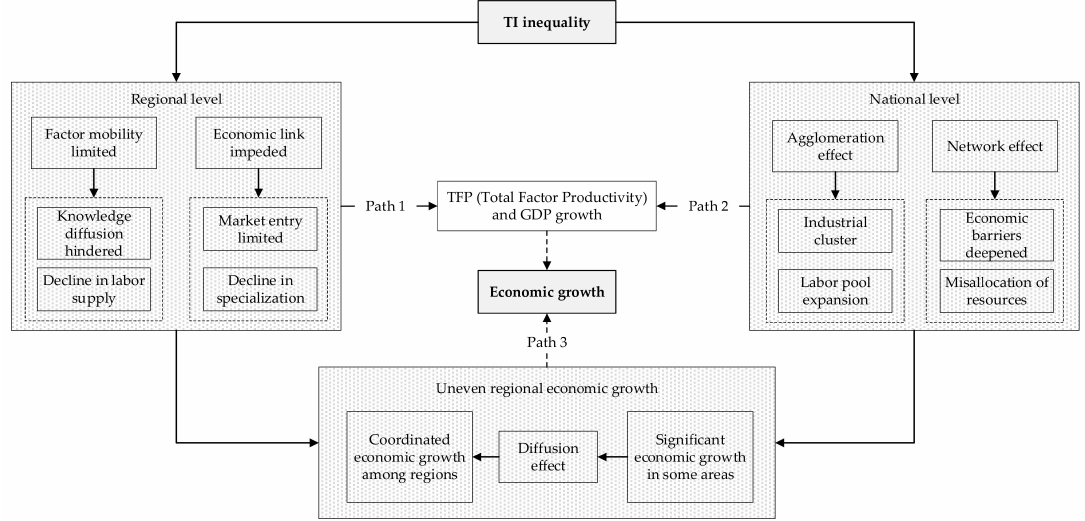
Figure 3. Influencing mechanism of TI inequality on economic growth. Note: → direct influence; (cid:57)(cid:57)(cid:75) potential